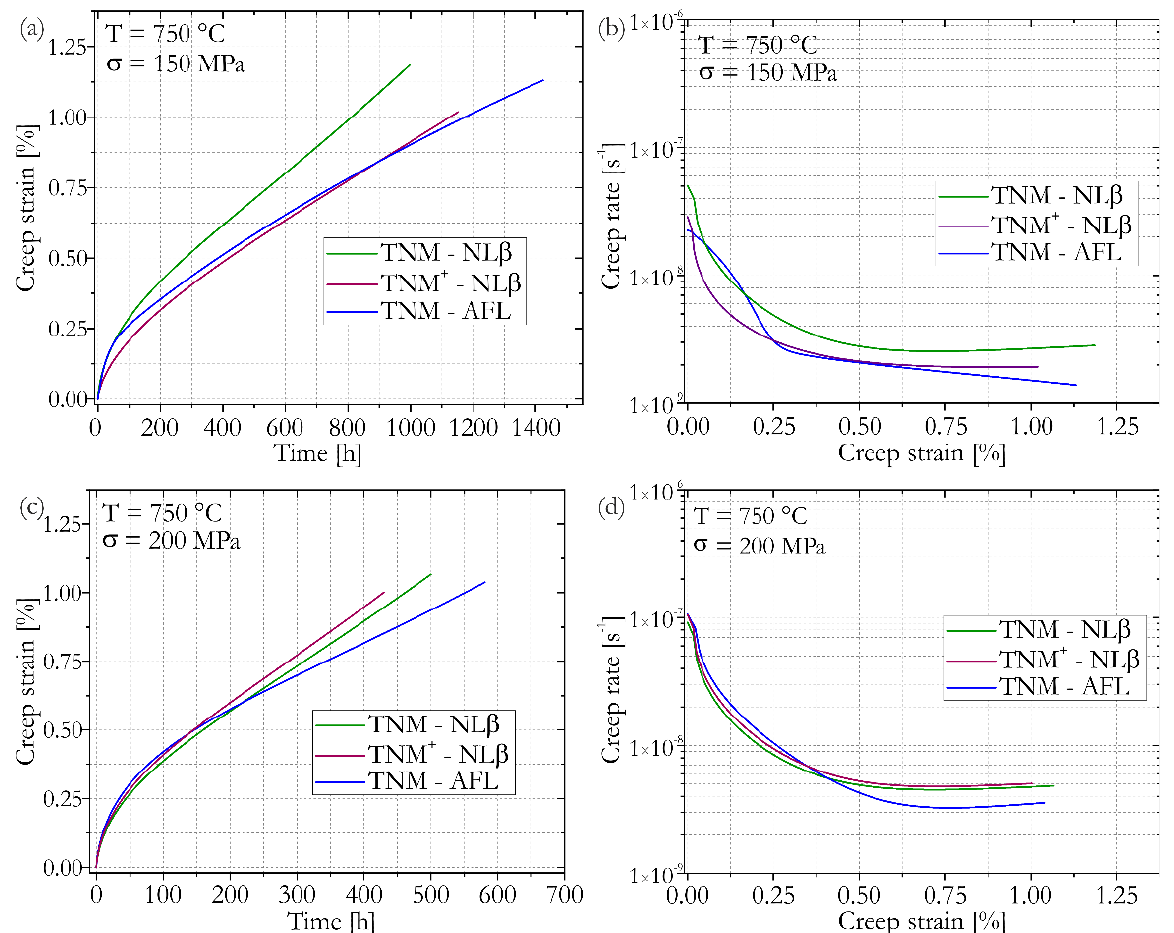
Figure 8. Creep results for the LPBF- TNM alloy with a NLβ and AFL microstructure , as well as the TNM + alloy with a NLβ microstructure tested at 750 °C: ( a ) creep strain over time for an initial stress of 150 MPa; ( b ) creep rate over creep strain tested with 150 MPa; ( c ) creep strain over time for 200 MPa; ( d ) creep rate over creep strain for 200 MPa.